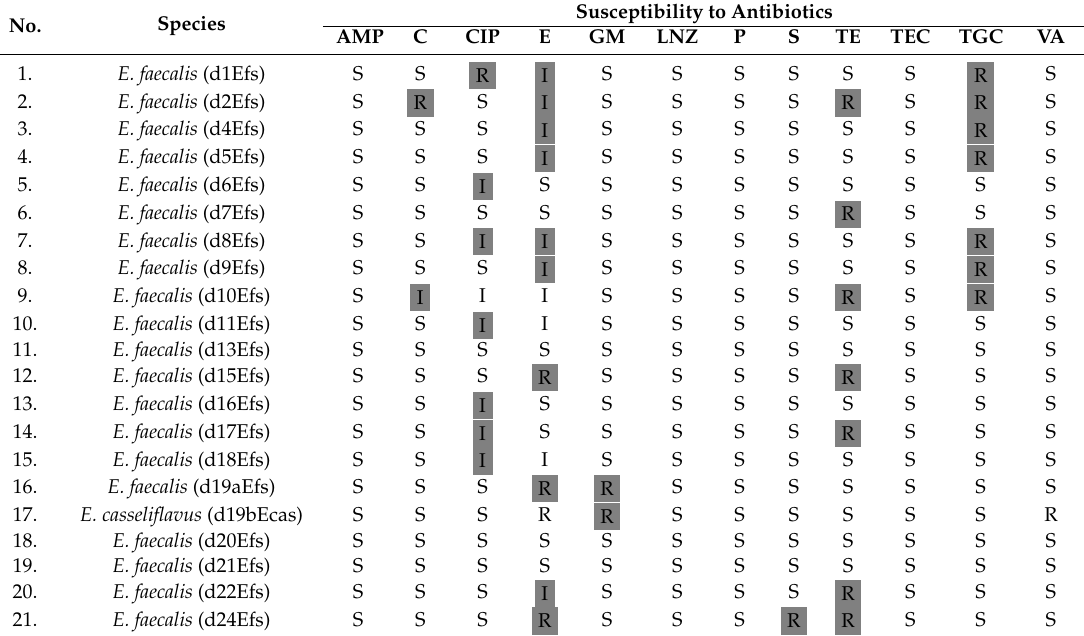
Table 1. Susceptibility pattern of Enterococcus